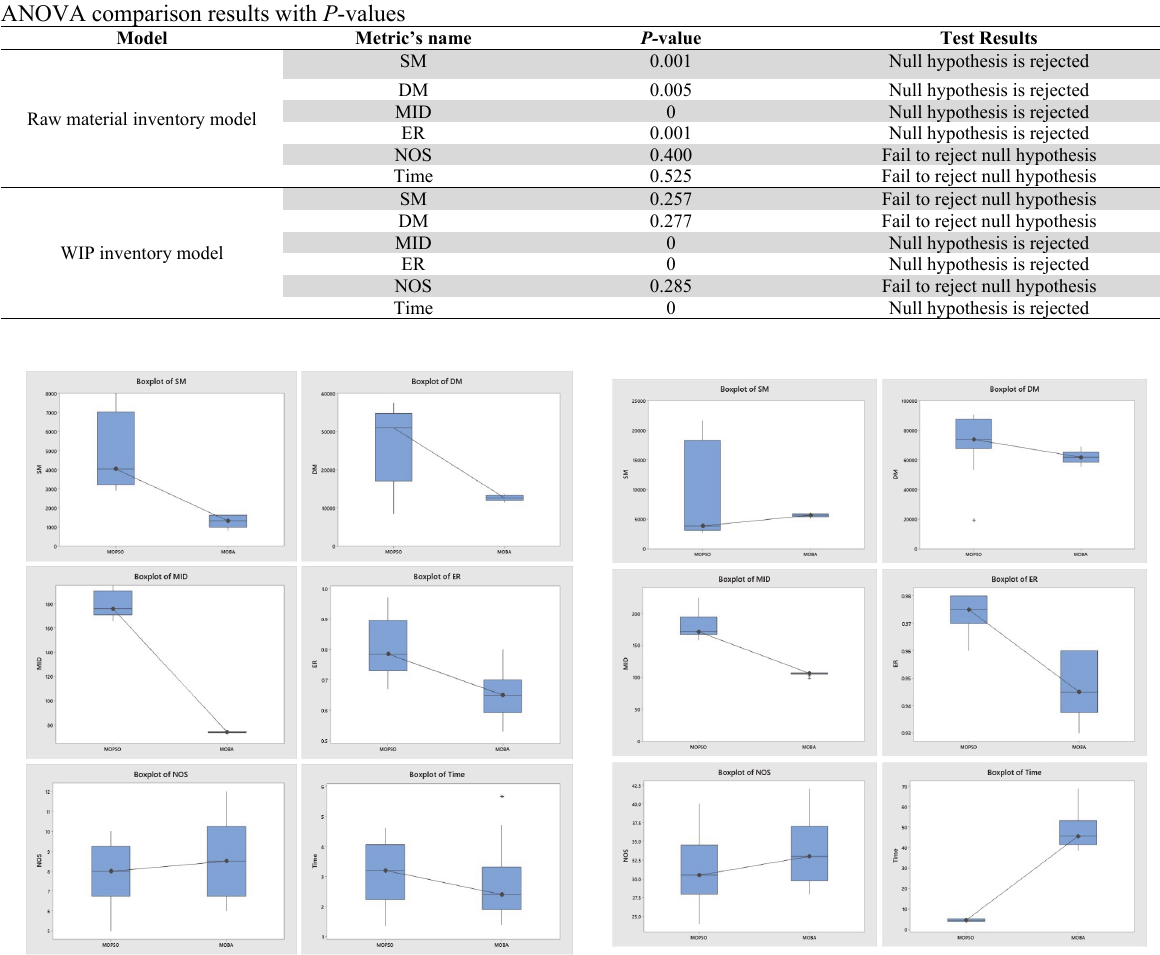
Fig. 10. Boxplots of metrics vs. algorithms (WIP inventory